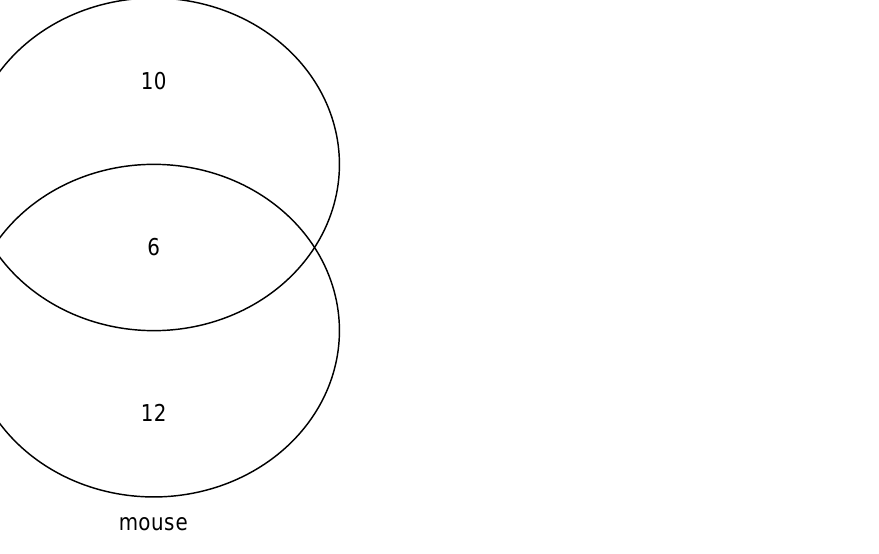
Figure 7. Venn diagram of KEGG pathways in "KEGG 2019 Human" category, selected by uploading genes selected by TD-based unsupervised FE to Enrichr. Table 7. Six commonly selected KEGG pathways from Figure